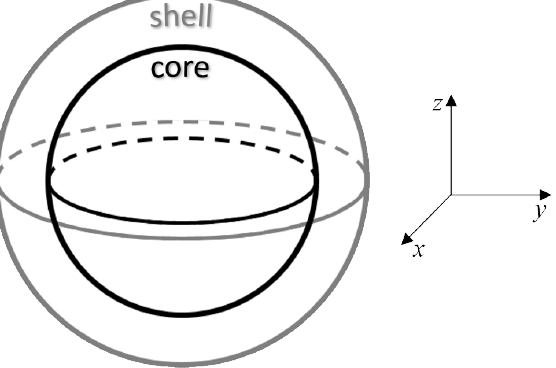
Figure 1. Basic geometry of a magnetic NP used in the micromagnetic simulations showing the real “core-shell” spin structure. The sketch of the coordinate system serves as a guideline for the external magnetic field and anisotropy axis directions used in the